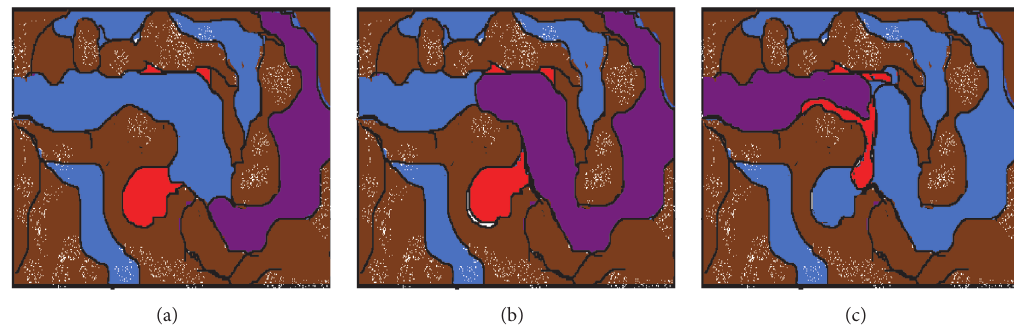
Figure 6: Negative pressure and viscoelasticity effect. Purple, weak gel; blue, water; red, oil.